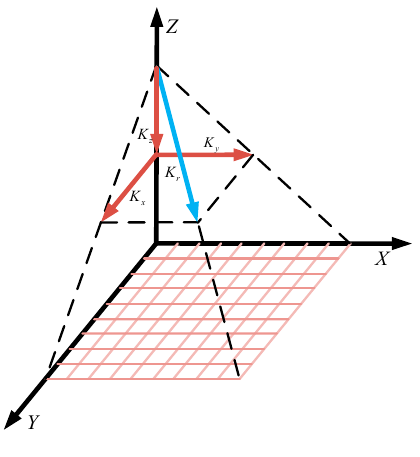
→ → K x , K y , (cid:0) (cid:1) x p , y p , (17) can also